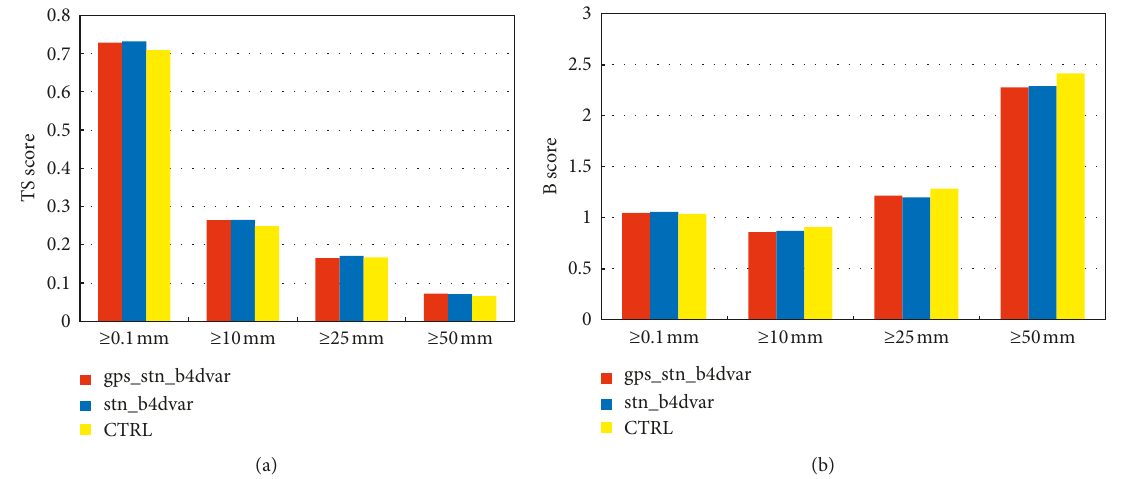
Figure 6: Comparison of the 24-hour cumulative precipitation (a) TS scores and (b) B scores for several schemes from May 4, 2009, to August 30, 2009.